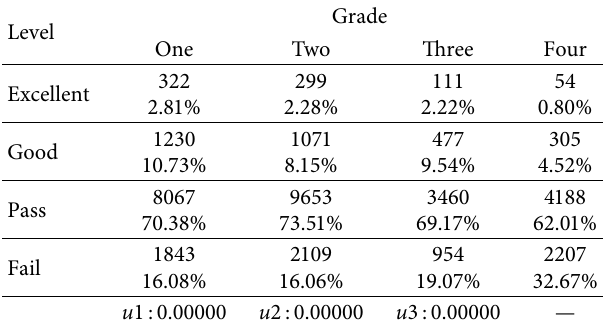
Table 9: Boys’ 1000-meter race scores and grade